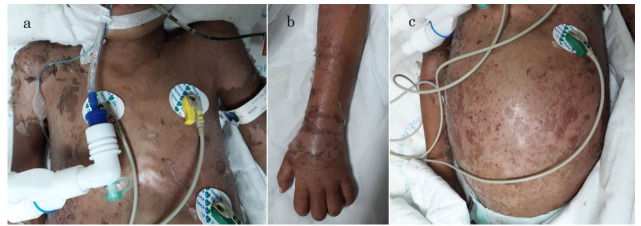
 Deterioration of patient condition a week later due to severe neutropenic enterocolitis (typhlitis) (Severe exfoliation occurred on September 21th.
The patient was transferred to PICU, and mechanical ventilation was started.)